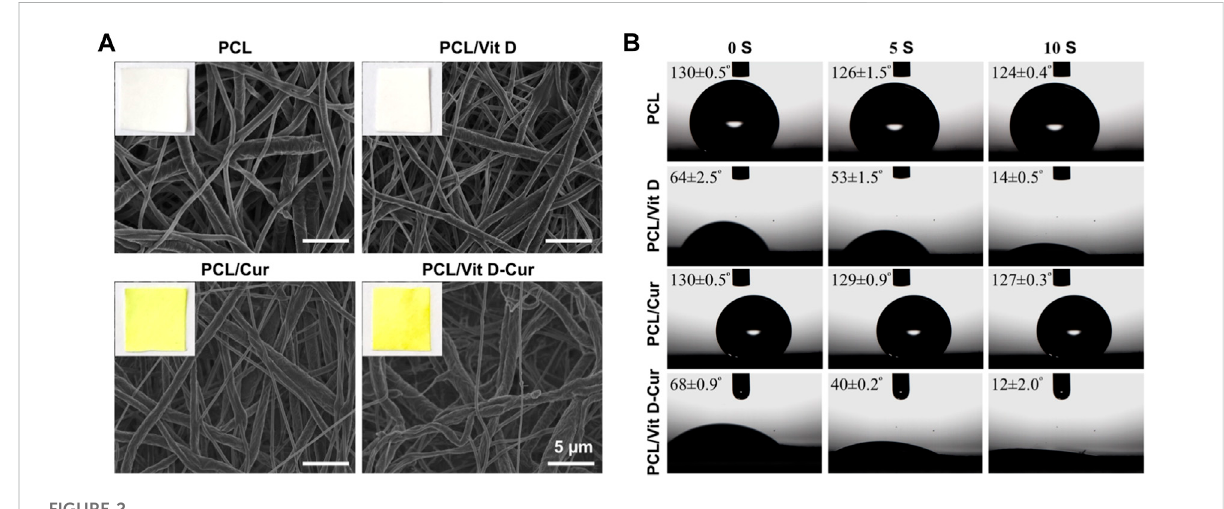
FIGURE 2 (A) SEM images, and (B) water contact angle of different